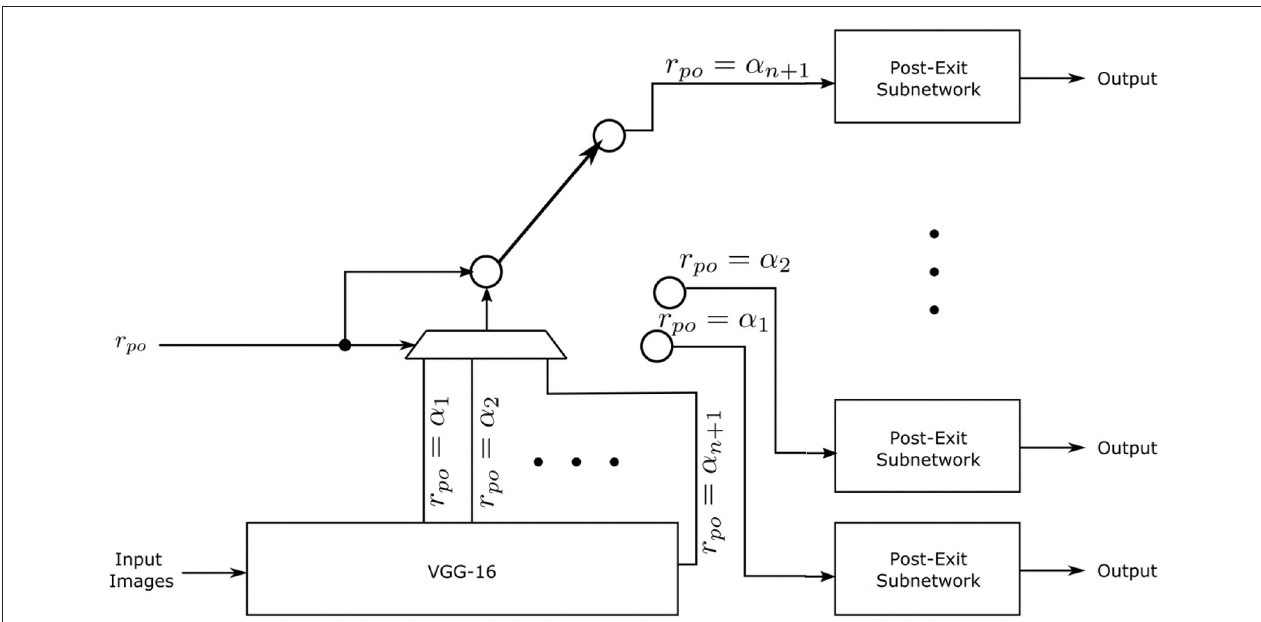
FIGURE 1 | An illustration of the elasticized SSD network architecture.